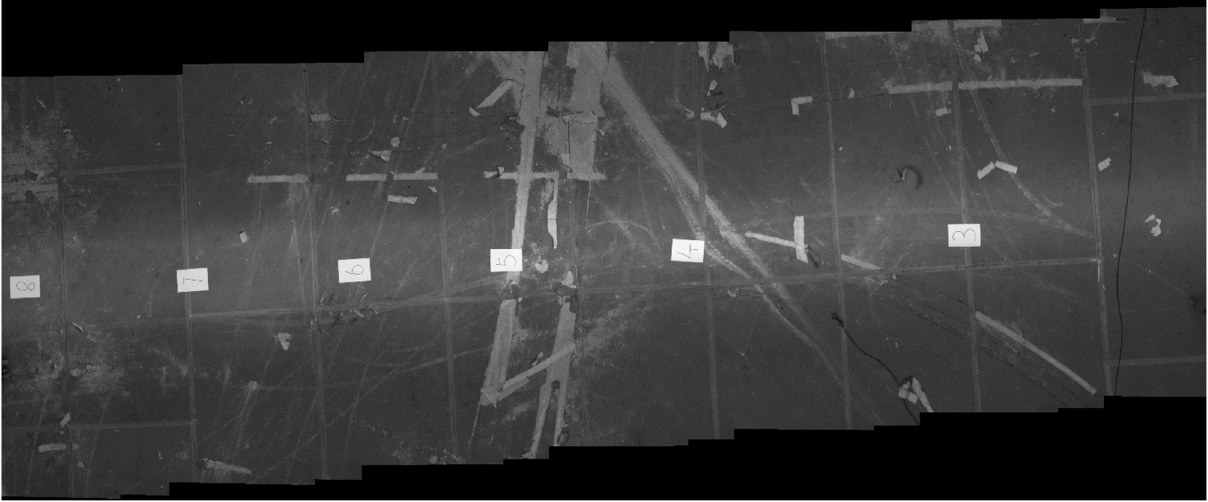
Figure 31. Whisk-broom ground test cover diagram.